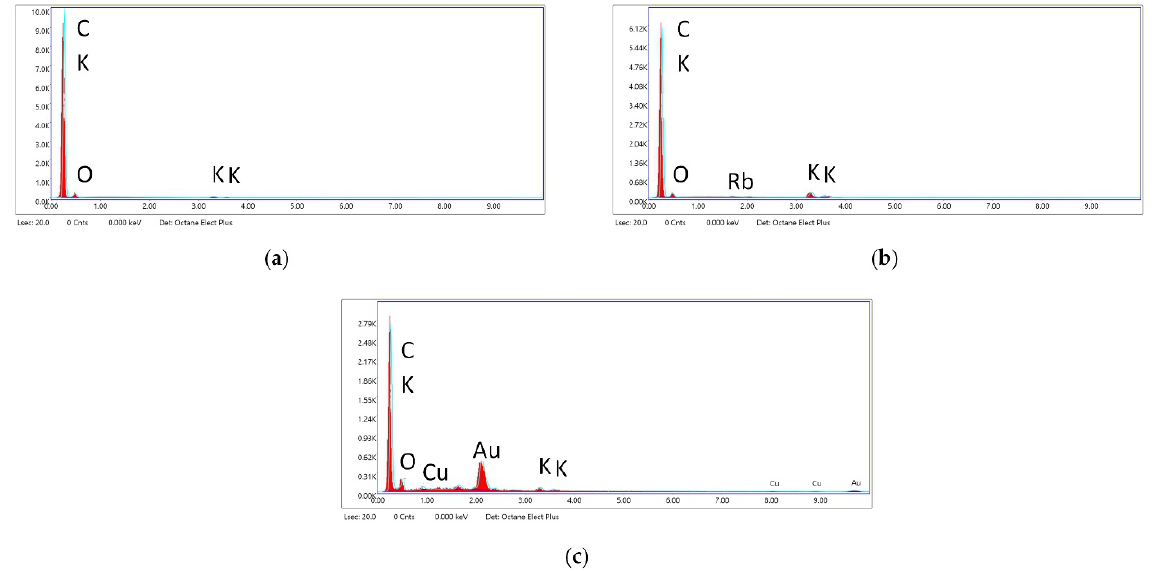
Figure 7. EDS analysis graph of CARBOSORB NC 1240 ® ( a ), AMBIOTON ® ( b ), and RE-CHAR ® ( c ) (kV: 15, Mag.: 249, Take-off: 35.3, Live Time: 20 s, Amp. Time: 0.96 µs, Resolution: 130 eV).